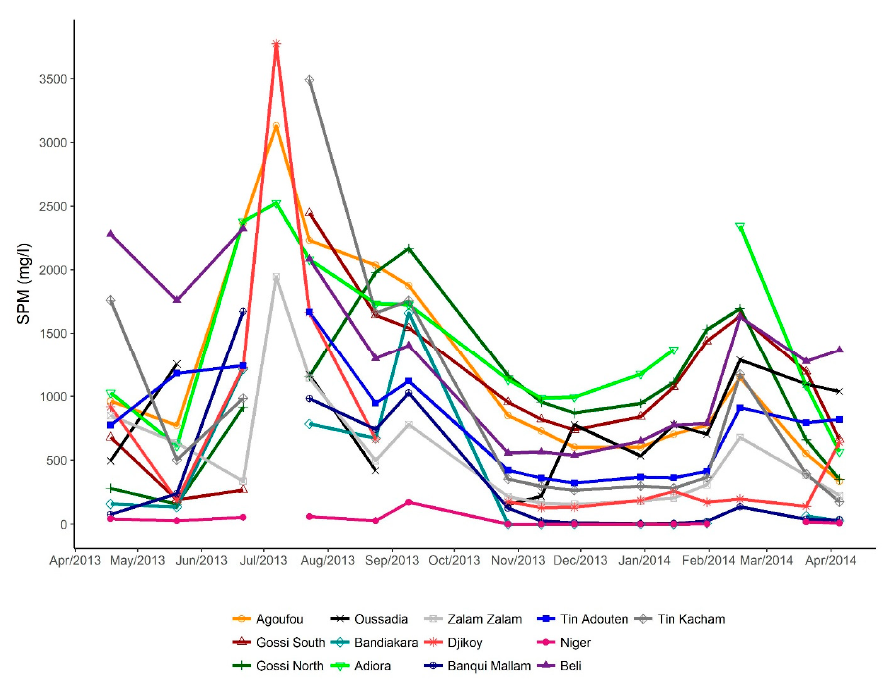
Figure 11. SPM seasonal cycle from Landsat 8 data for quasi-permanent water bodies in the Gourma Region (2013–2014).